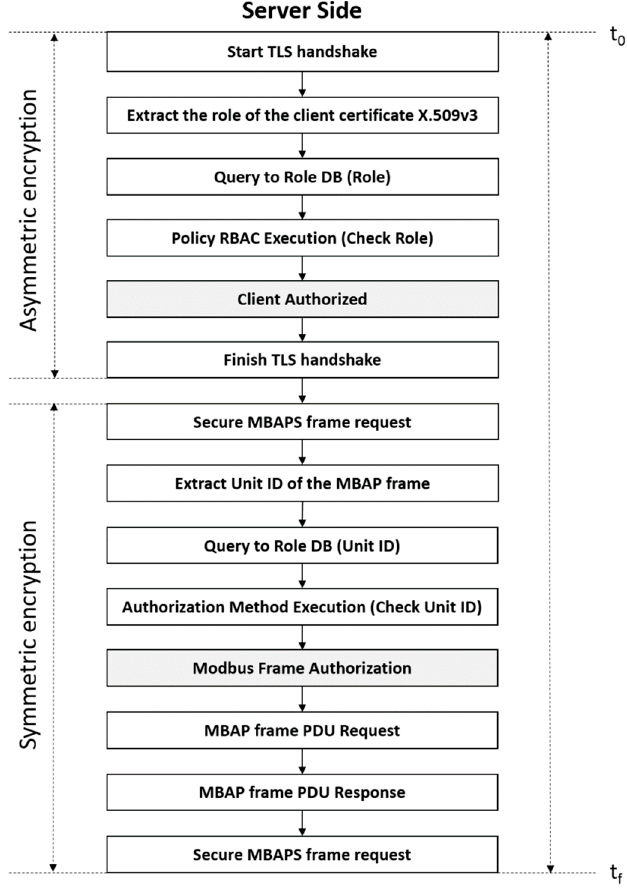
Figure 6. Step-by-step, successful server-side; the two-authorization process.